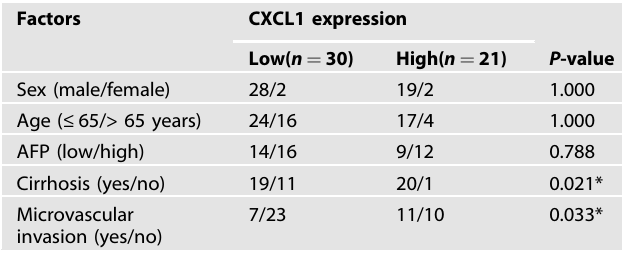
Table 1. Correlation between CXCL1 expression in tumour tissues from HCC patients and corresponding clinicopathologic